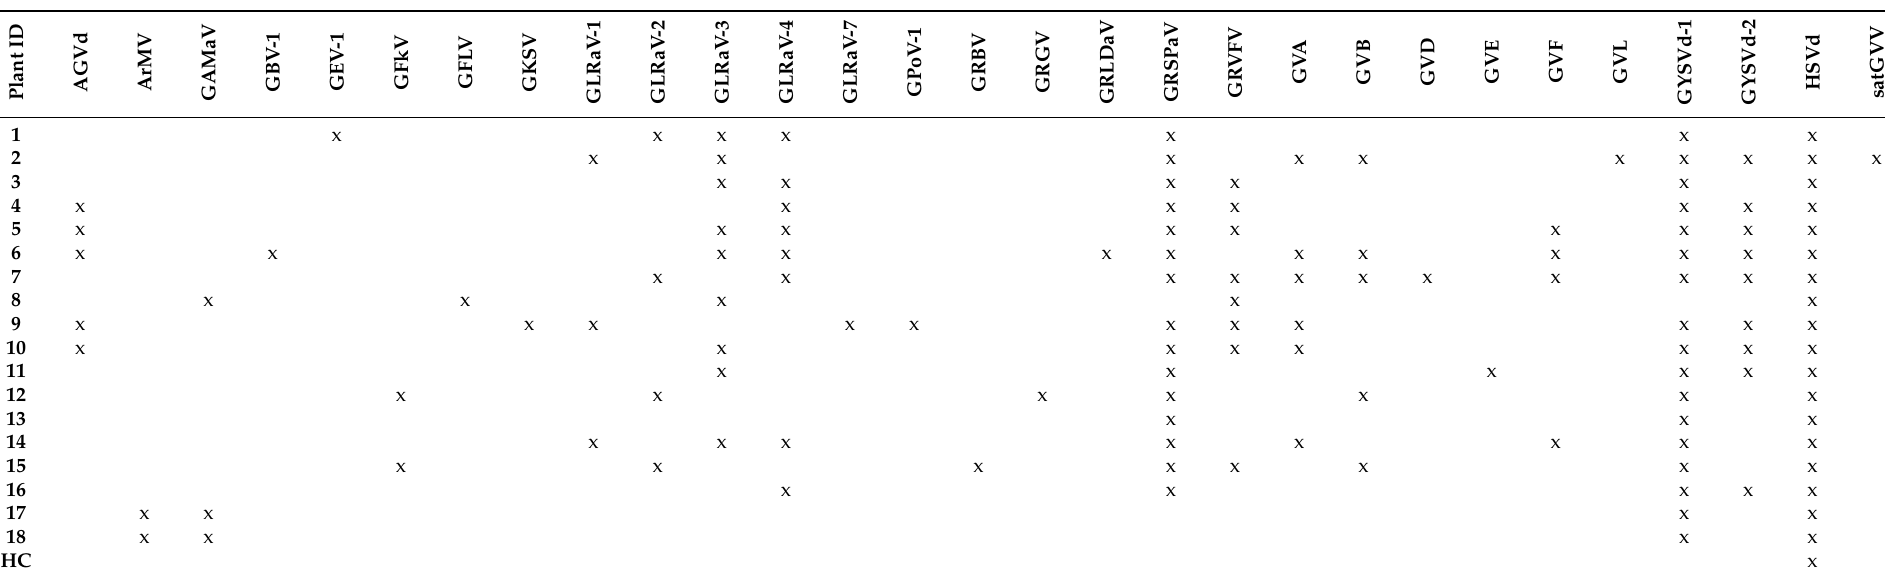
Table 1. Viruses or viroids detected in selected vines collected from Davis Virus Collection and FPS foundation vineyard